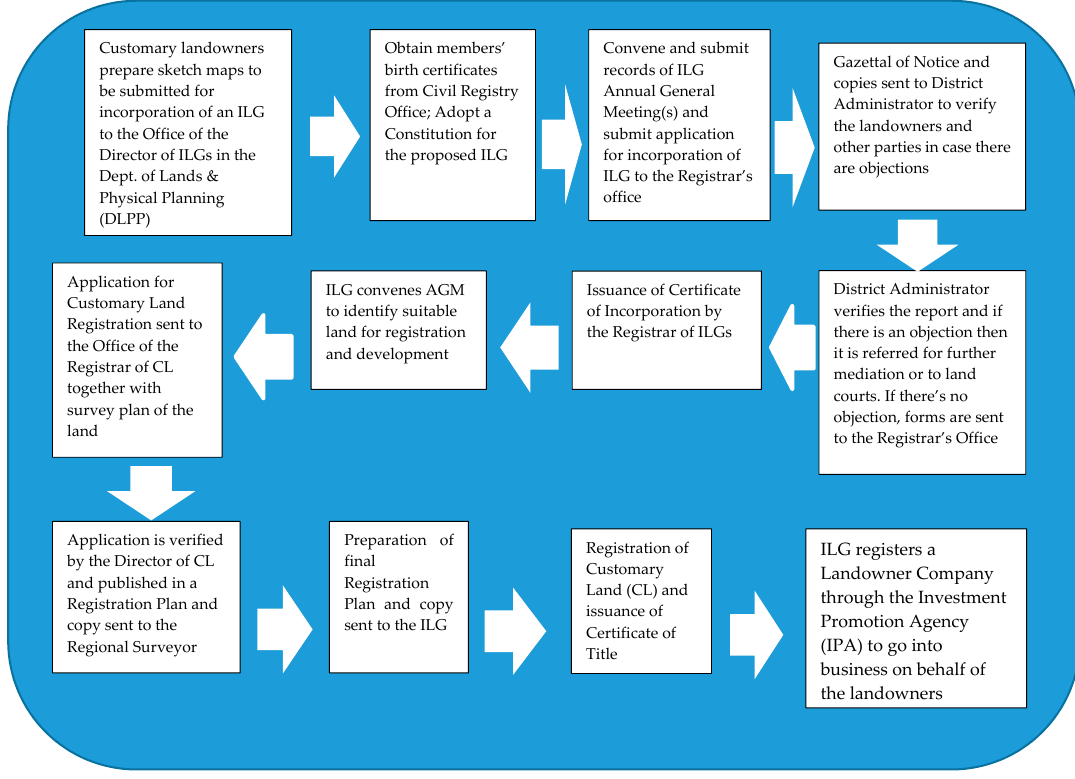
Figure 3. A Modified Incorporated Land Group (ILG) Incorporation and Customary Land Registration Process. Source: After